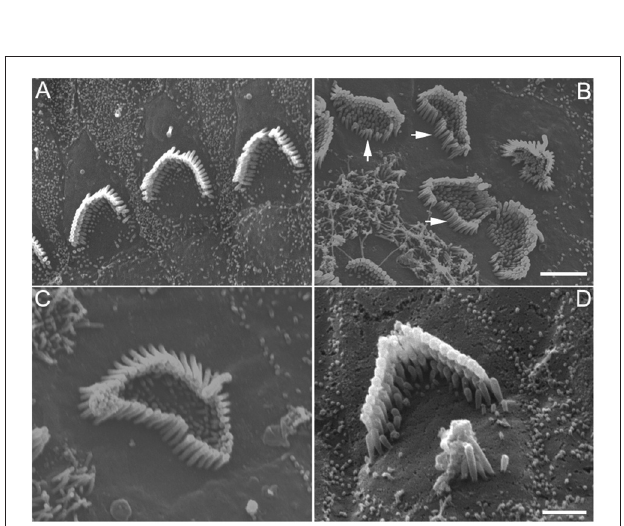
FIGURE 2 | Scanning electron microscopy (SEM) micrographs of stereocilia bundles from 8-day-old cultures prepared from the low apical turn. (A) An SEM micrograph obtained from a culture without DAPT treatment (control). Inner hair cell (IHC) and outer hair cell (OHC) regions are marked by white lines. (B–F) Examples of stereocilia bundles of hair cell-like cells (HCLCs) from DAPT-treated cultures. A black arrow in (B) or (C) indicates the stereocilia bundles of IHCs. White arrows in (B–E) indicate various forms of stereocilia bundles seen in the apical surface of HCLCs. Black arrows in (E) and (F) mark the same stereocilia bundle with a higher magnification in (F) . (G) SEM image from a culture treated with 5 µ M LY411575. Scale bars: 5 µ m for all images.